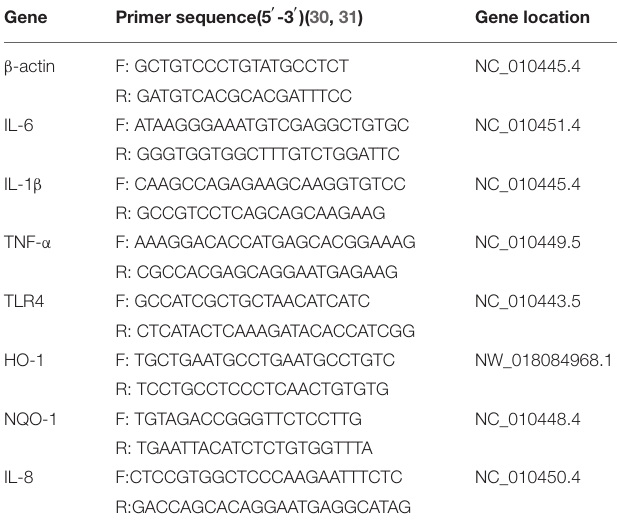
TABLE 2 | Primers used for real-time